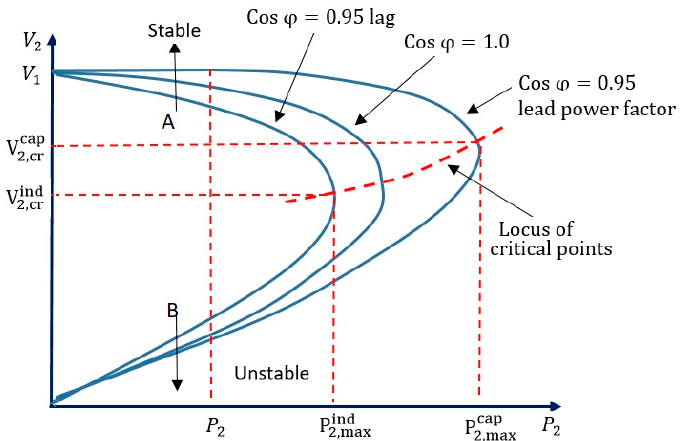
Figure 3. Effect of reactive power compensation on the P-V